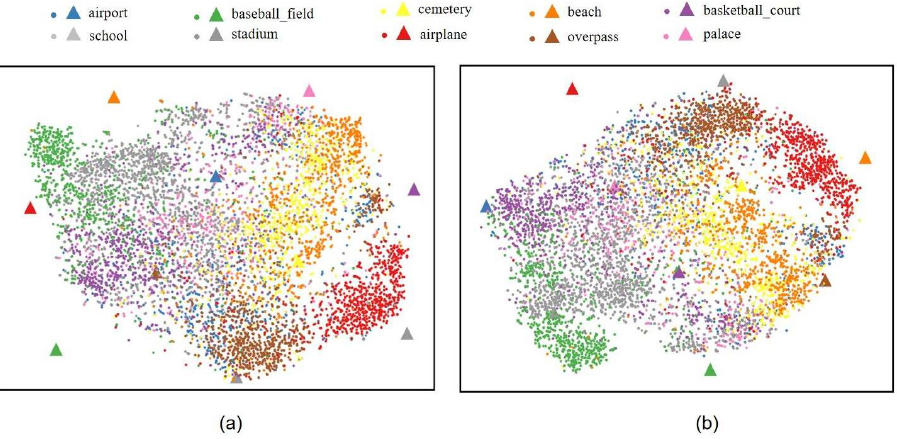
Figure 6. T-SNE visualization of the cross-model feature alignment between the visual ( (cid:5) ) and semantic ( (cid:78) ) features of unseen image scenes in the latent